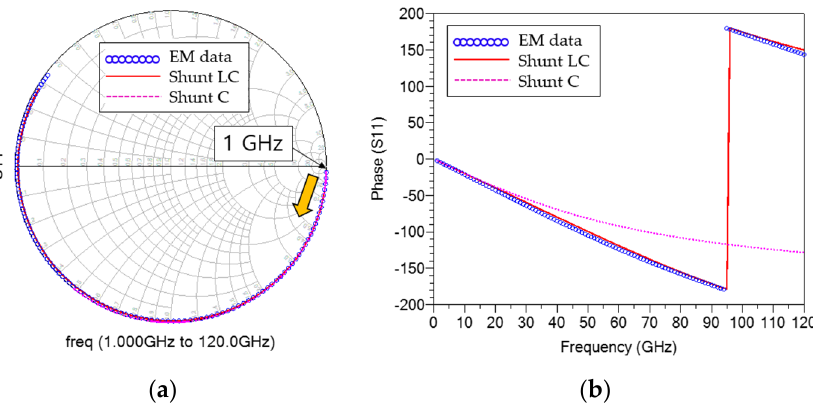
Figure 4. Comparison of S11 ( a ) on the Smith chart and ( b ) on the phase between EM data and equivalent circuits.